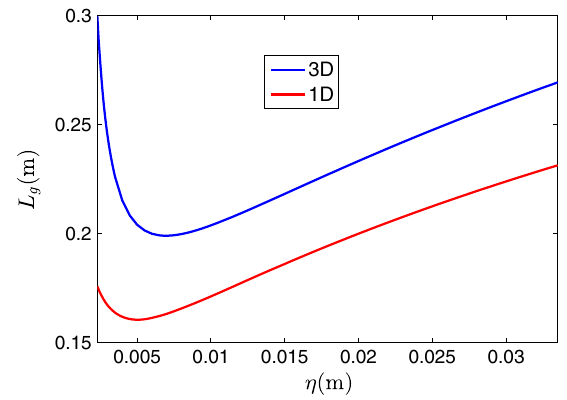
FIG. 1. Frequency-optimized gain length of the fundamental mode as a function of the dispersion for the LPA parameters. The data shown were obtained using the variational solution (blue) and the 1D fitting formula mentioned in the text